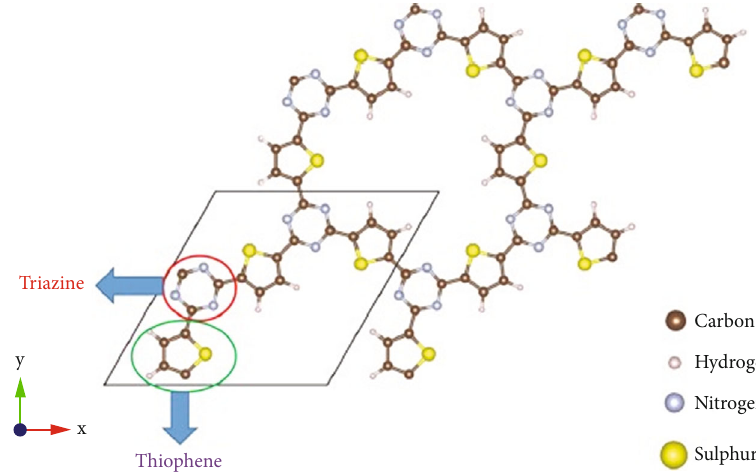
Figure 1: The geometric structure of L